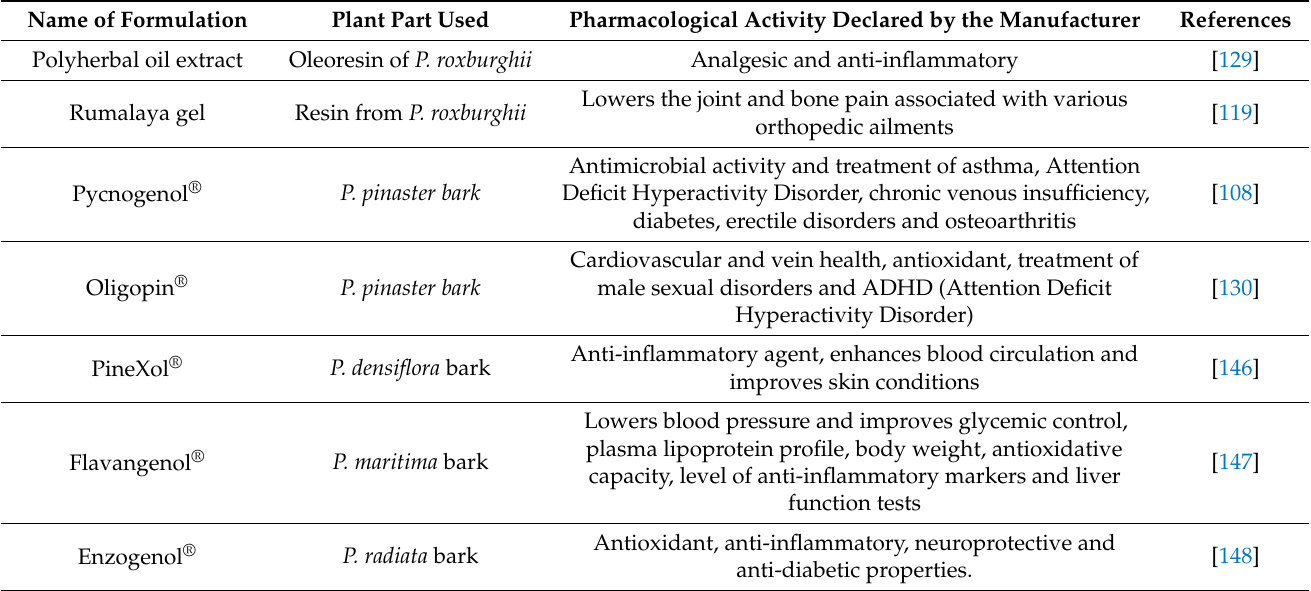
Table 8. Commercial pharmacological products from